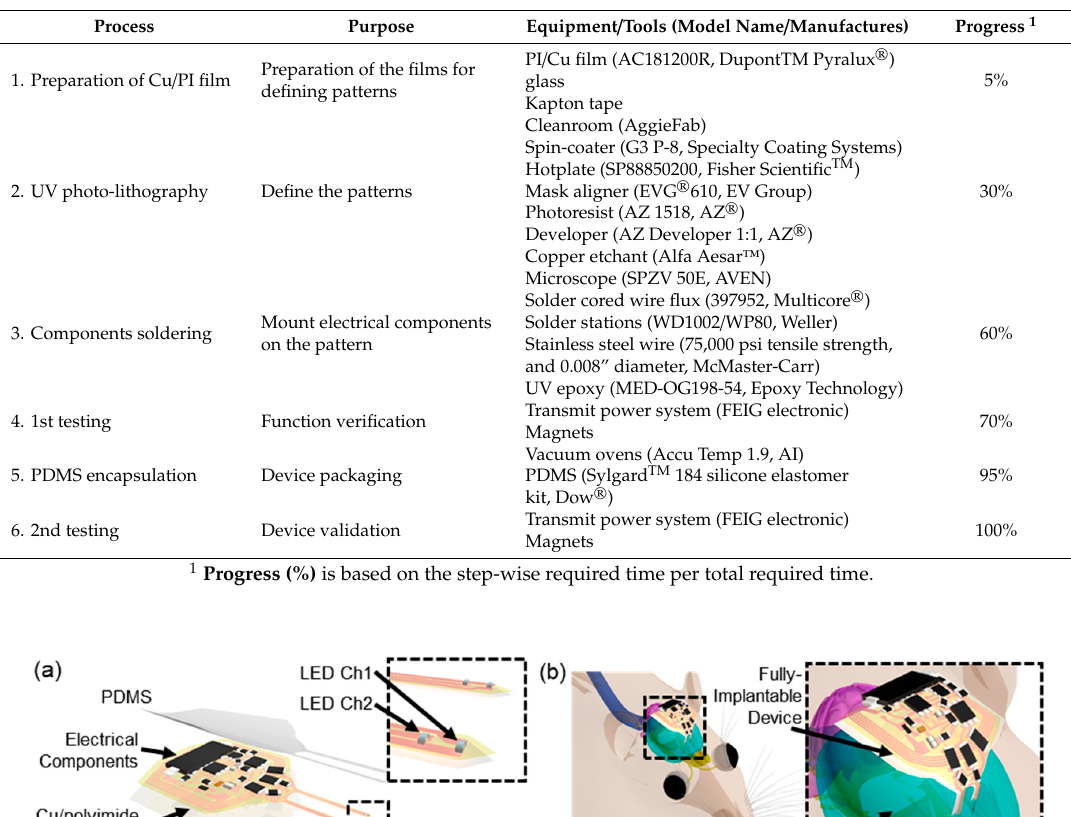
Table 1. Step by step procedures for the fabrication of the low-power, wireless optoelectronic devices.